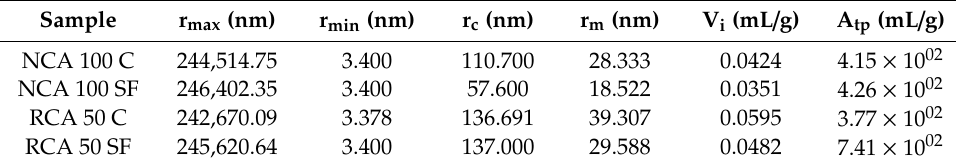
Table 7. Porous network indicators in Hg intruded stage.